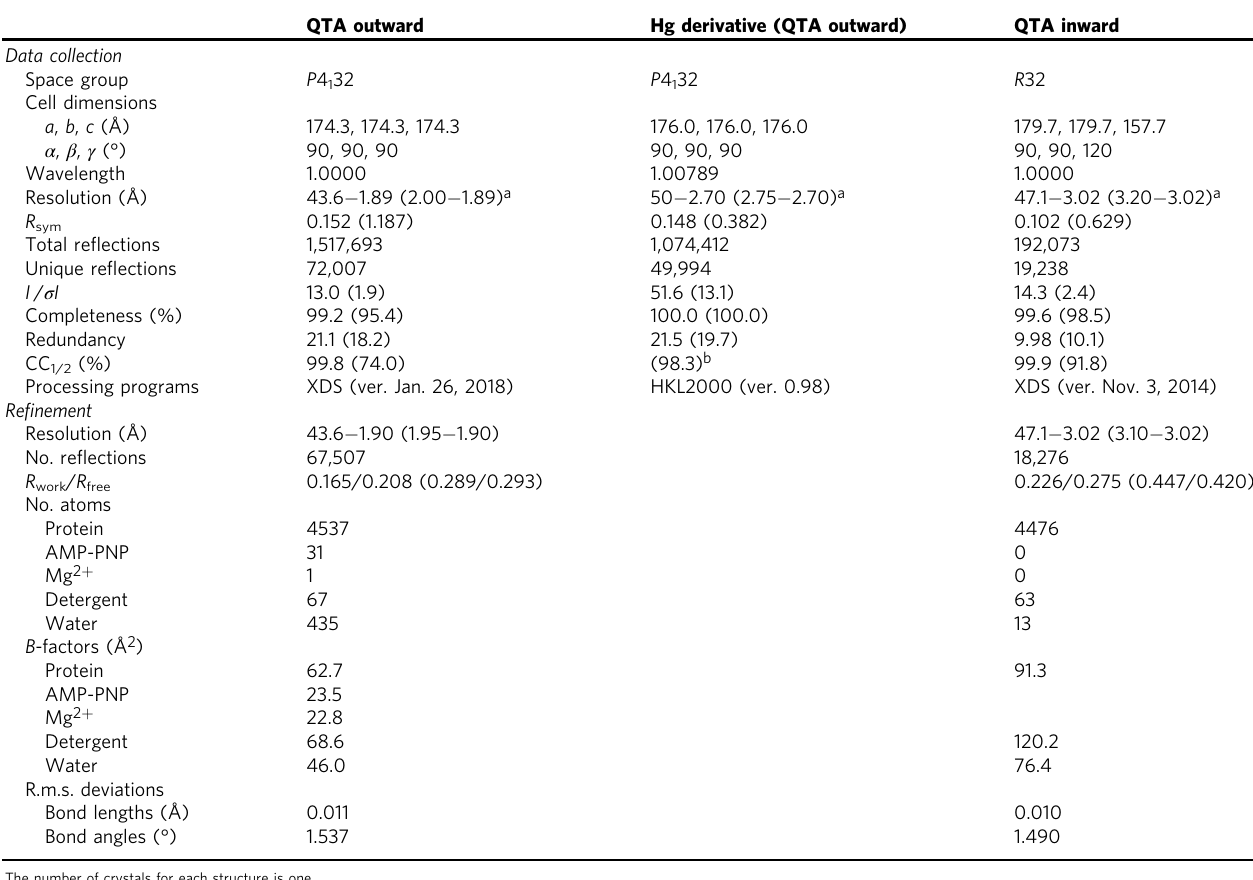
Table 1 Data collection and re fi nement